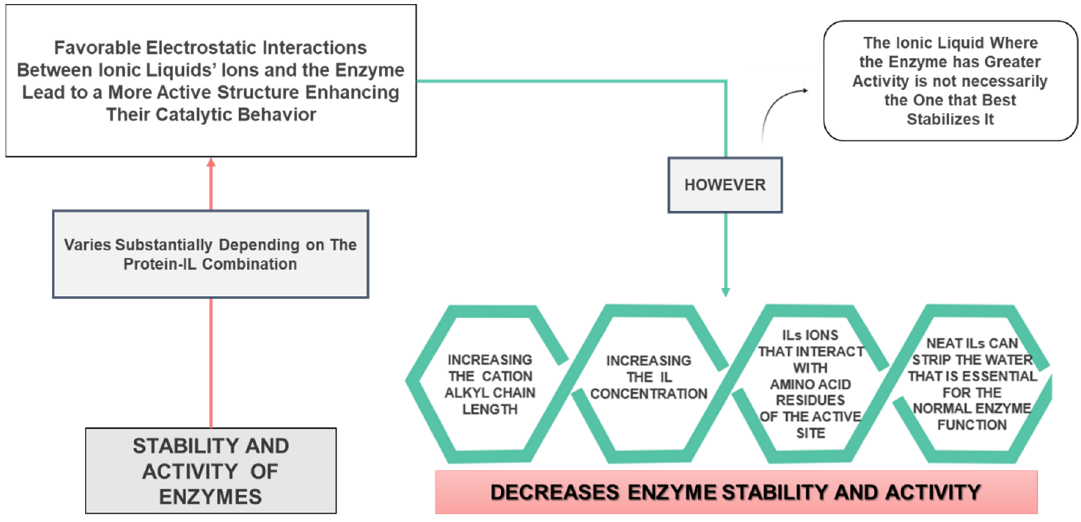
Figure 4. Scheme summarizing advantages and disadvantages of ionic liquids as reaction media for